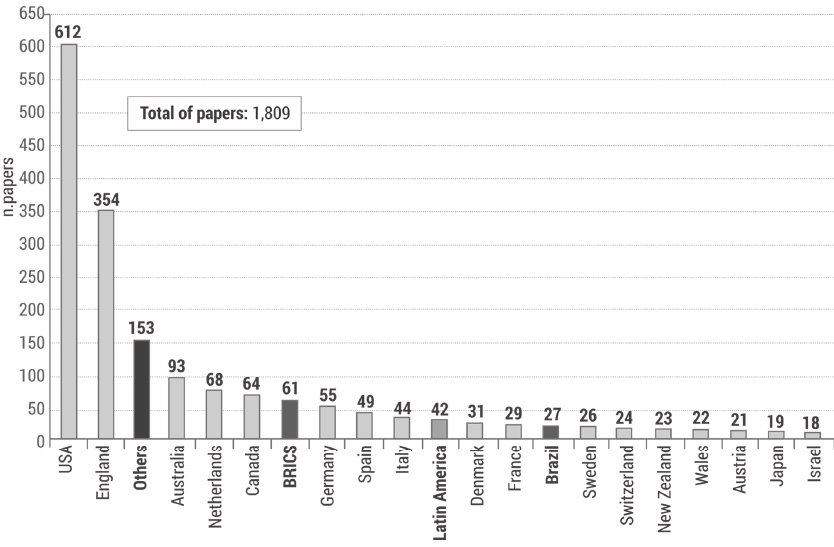
Figure 4 - Paper contributions by country in 3 journals of science communication: Public Understanding of Science ; Science Communication and Journal of Science Communication . Based in data collected in Web of Science and Scopus